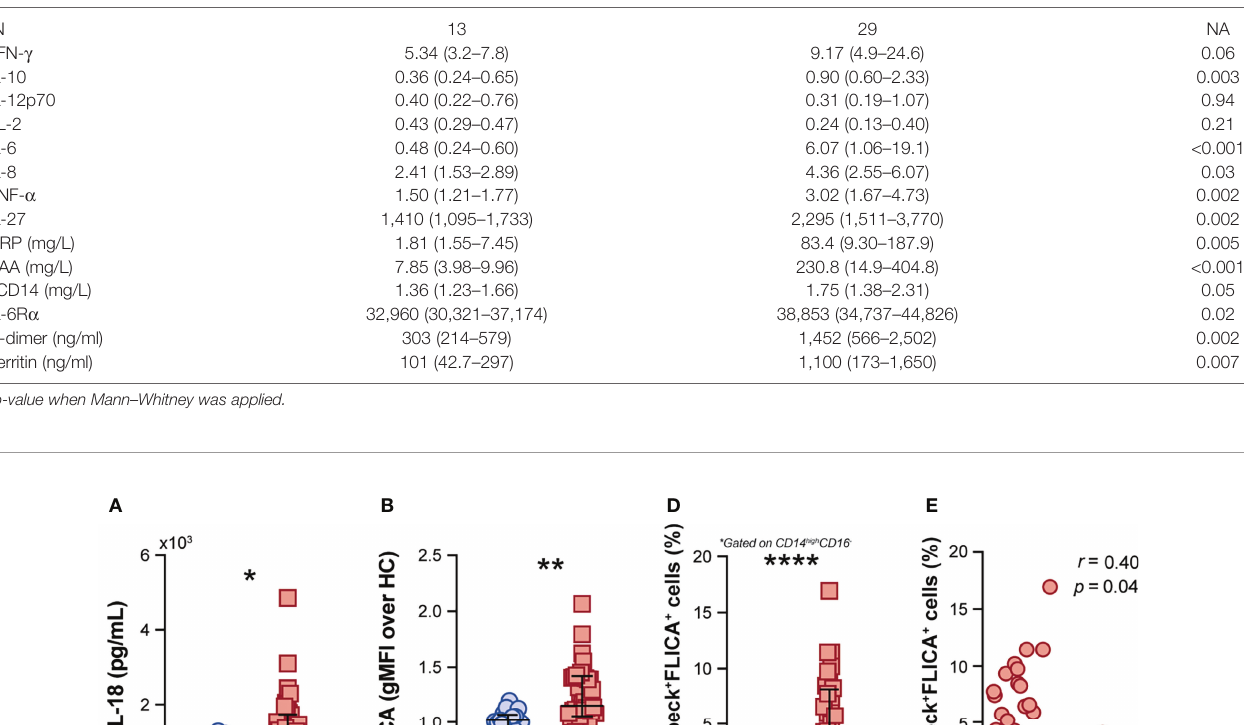
TABLE 2 | Plasma biomarkers measurement in healthy controls (HC) versus COVID-19 patients (median values with IQR in parenthesis). Biomarker (pg/ml)